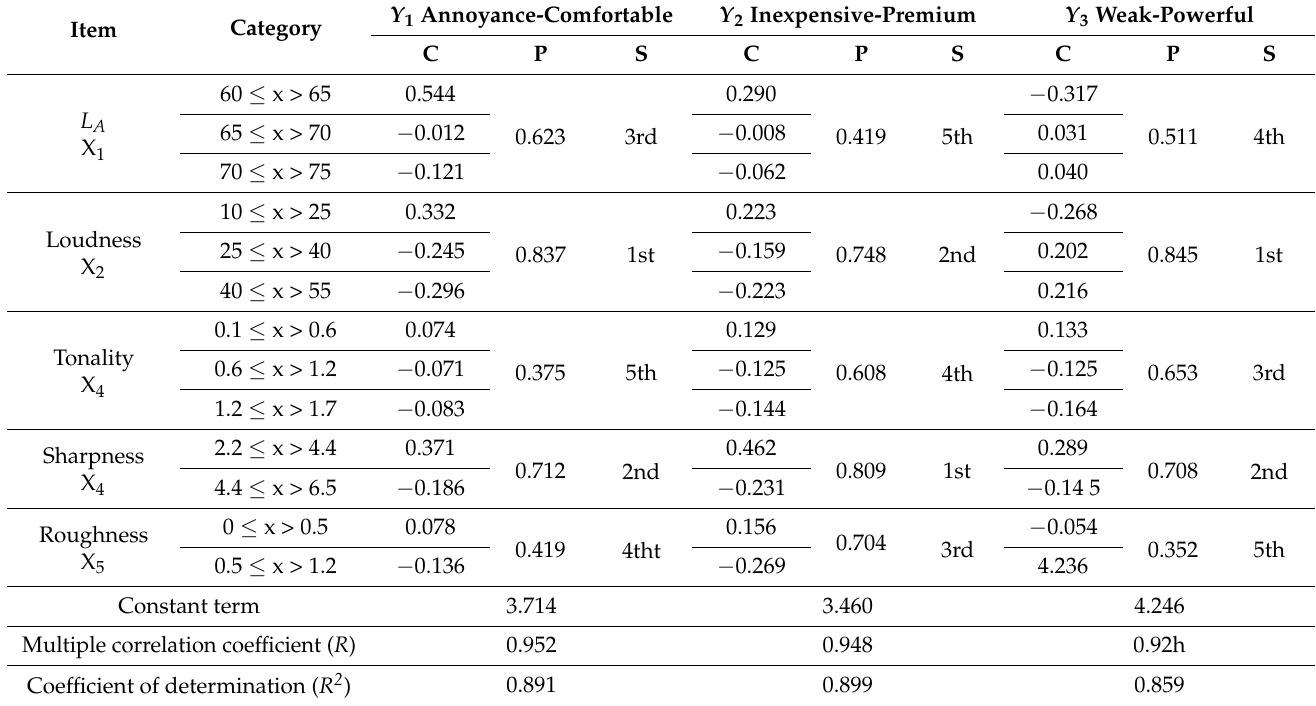
Table 4. Kansei impact analysis for each item and category in the QTTI prediction